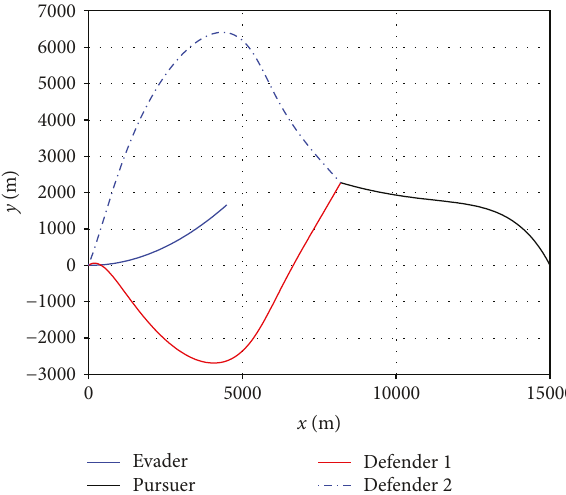
Figure 15: Four aircraft fl ight trajectories (two-side intercept with cooperation of Evader).